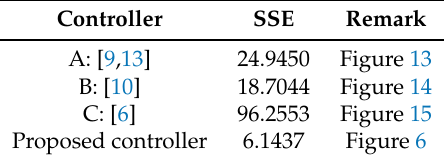
Table 2. Comparison